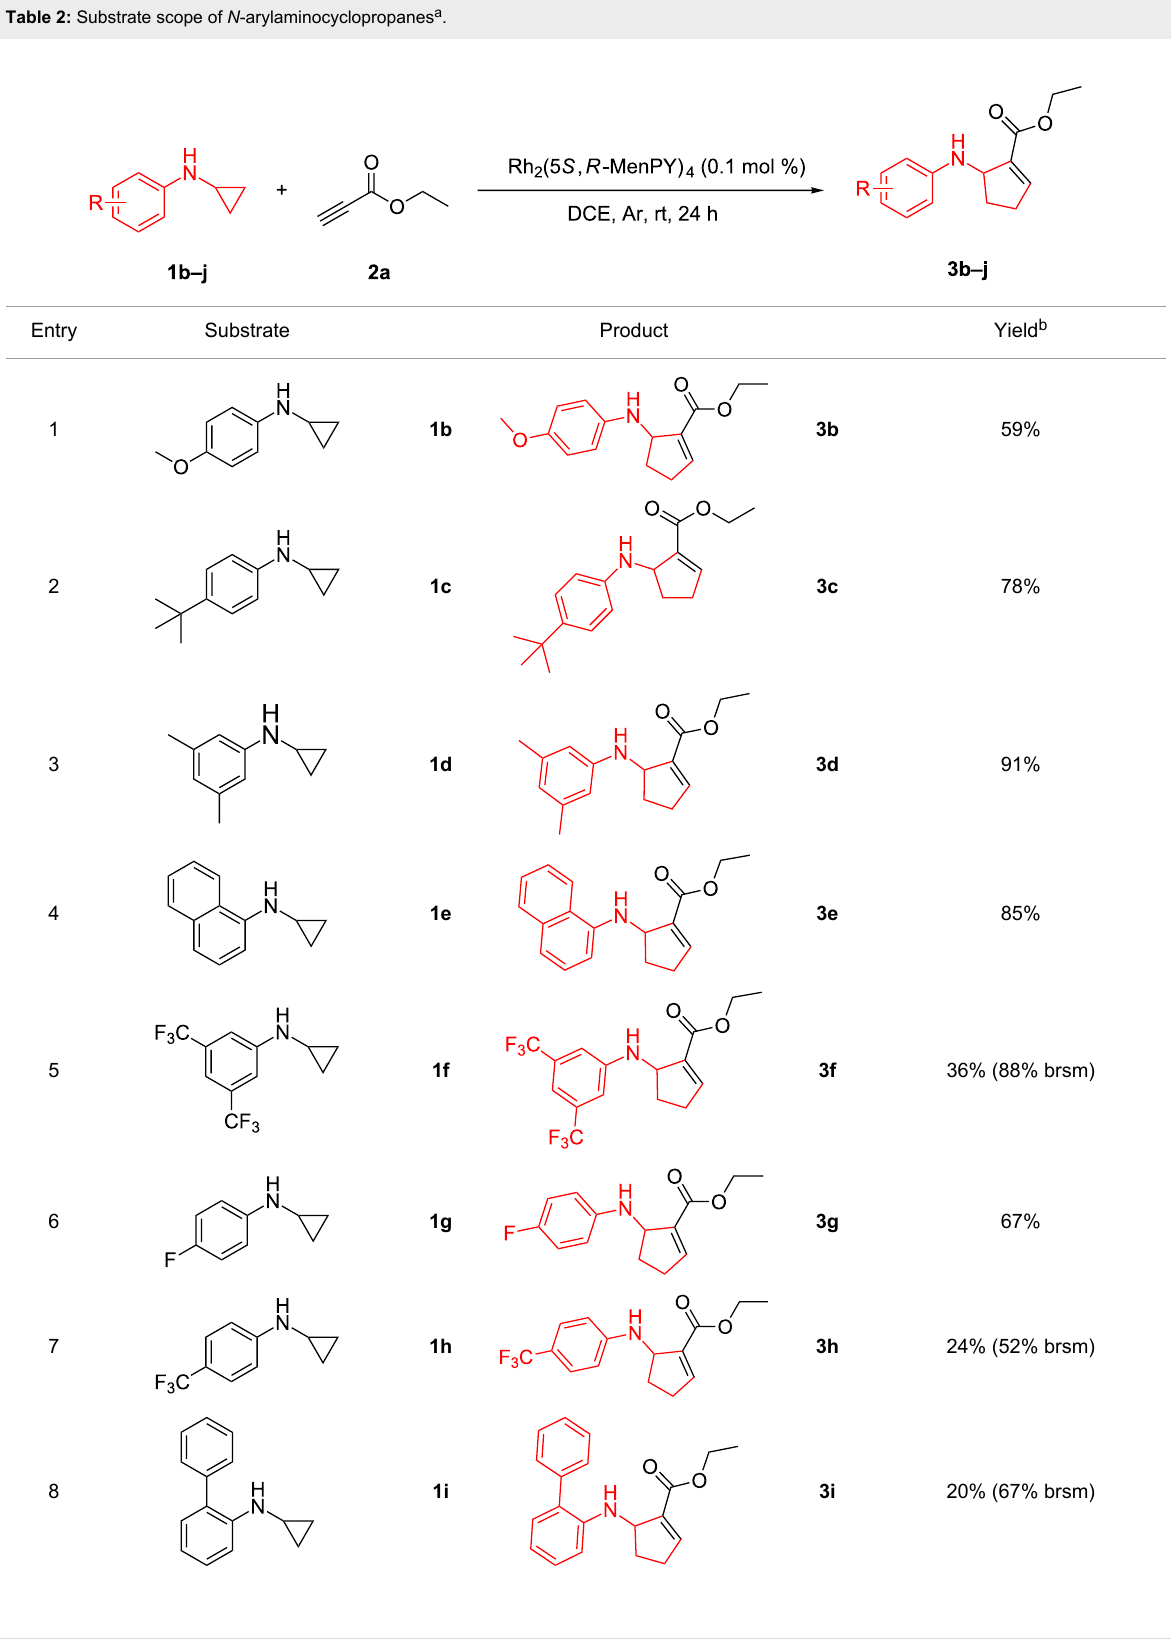
Table 2: Substrate scope of N -arylaminocyclopropanes a